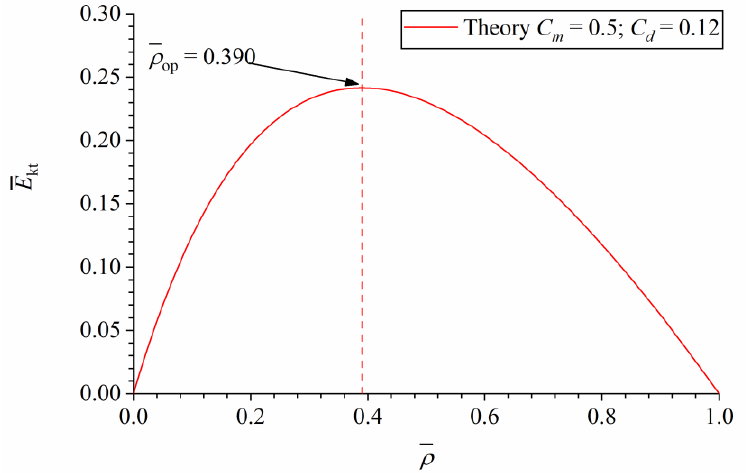
Figure 19. Dimensionless kinetic energy of the sphere versus dimensionless density of the sphere with h = 0.089 and L 0 =